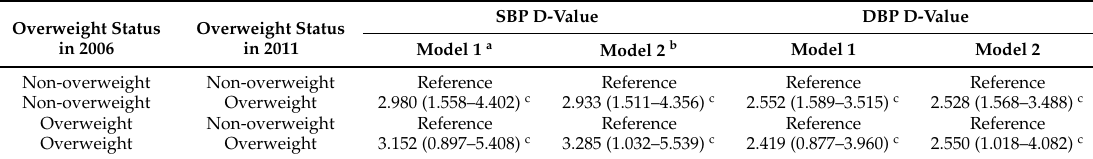
Table 4. The association between SBP D-value and DBP D-value and change in overweight status between 2006 and